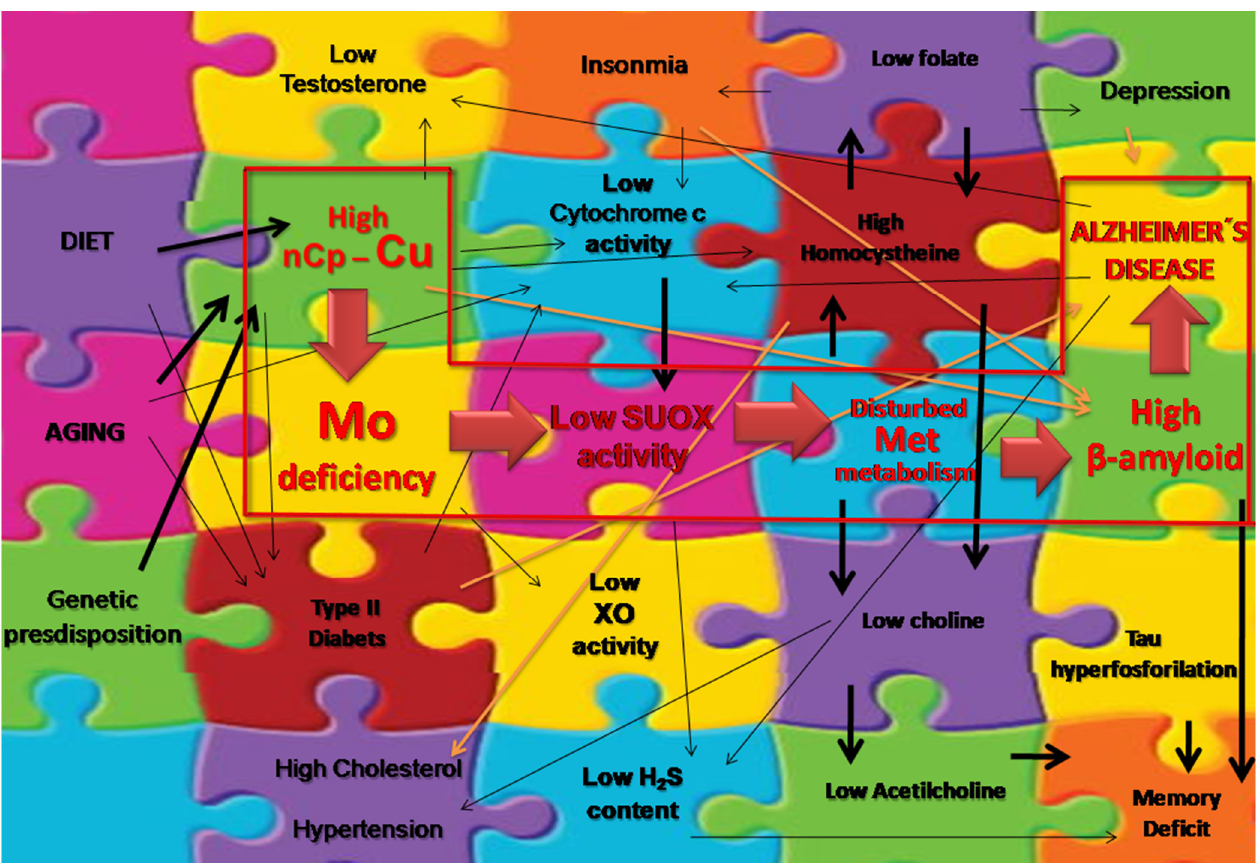
Figure 2. Summary of proposed cellular/molecular mechanisms for the Cu–Mo–S circuitry in AD pathology or multiple AD-associated factors.